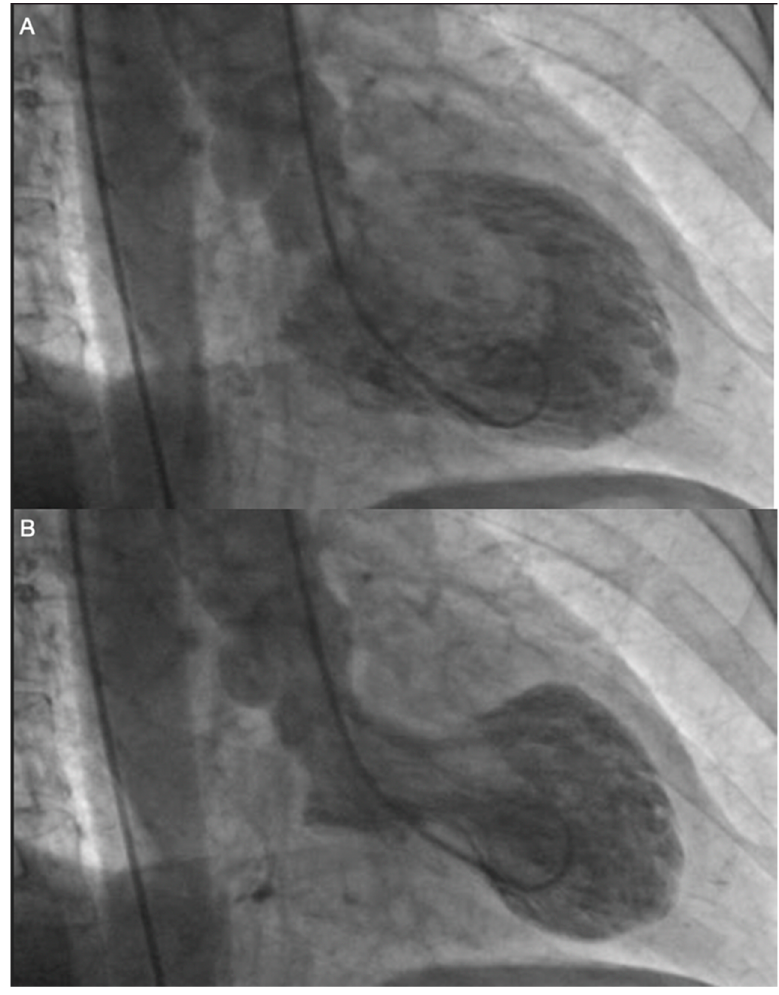
Figure 2. Angiography in a patient with typical (apical) form of TTS. ( A ) left ventricle in diastole. ( B ) left ventricle in systole. Right ventricle dysfunction is observed in approximately 30% of patients with TTS [24]. It should be emphasized that due to hyperkinesis of the right ventricle inflow tract,